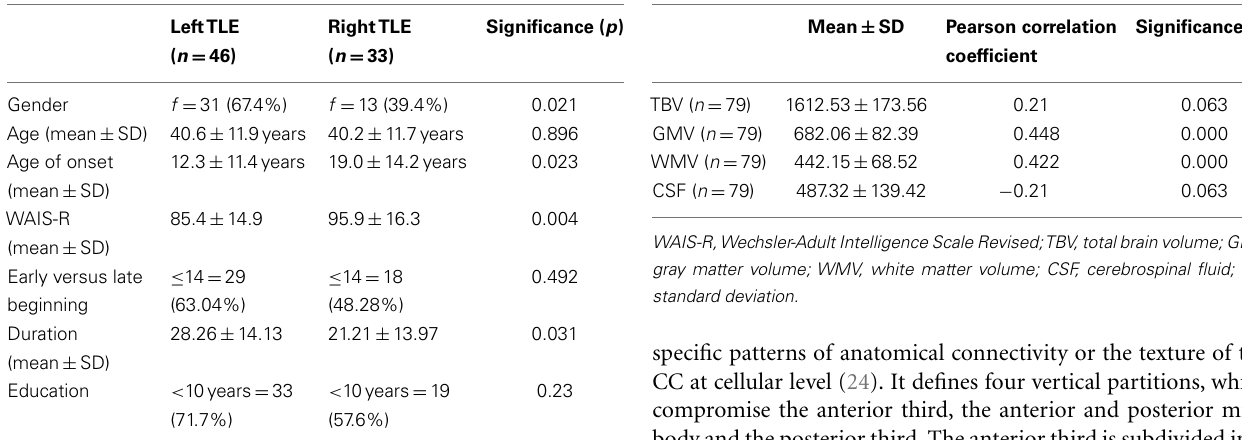
Table 2 | Demographics and clinical characteristics. Table 3 | Correlation analysis ofWAIS-R and brain